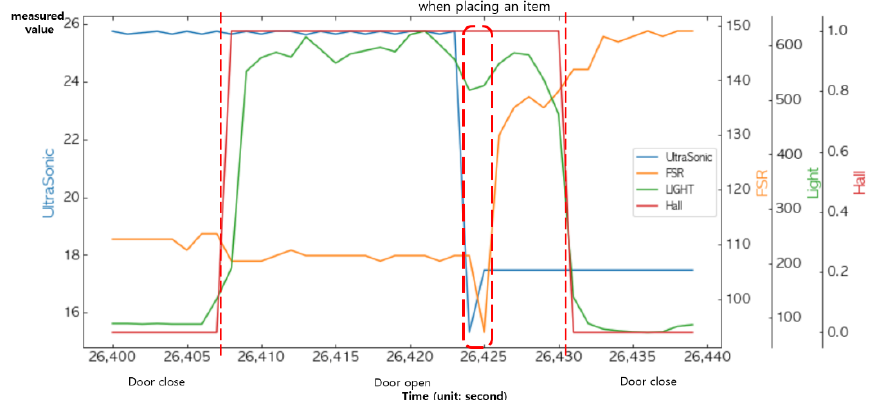
Figure 21. Changes in the sensed values when placing an item in and taking it out from the smart storage.